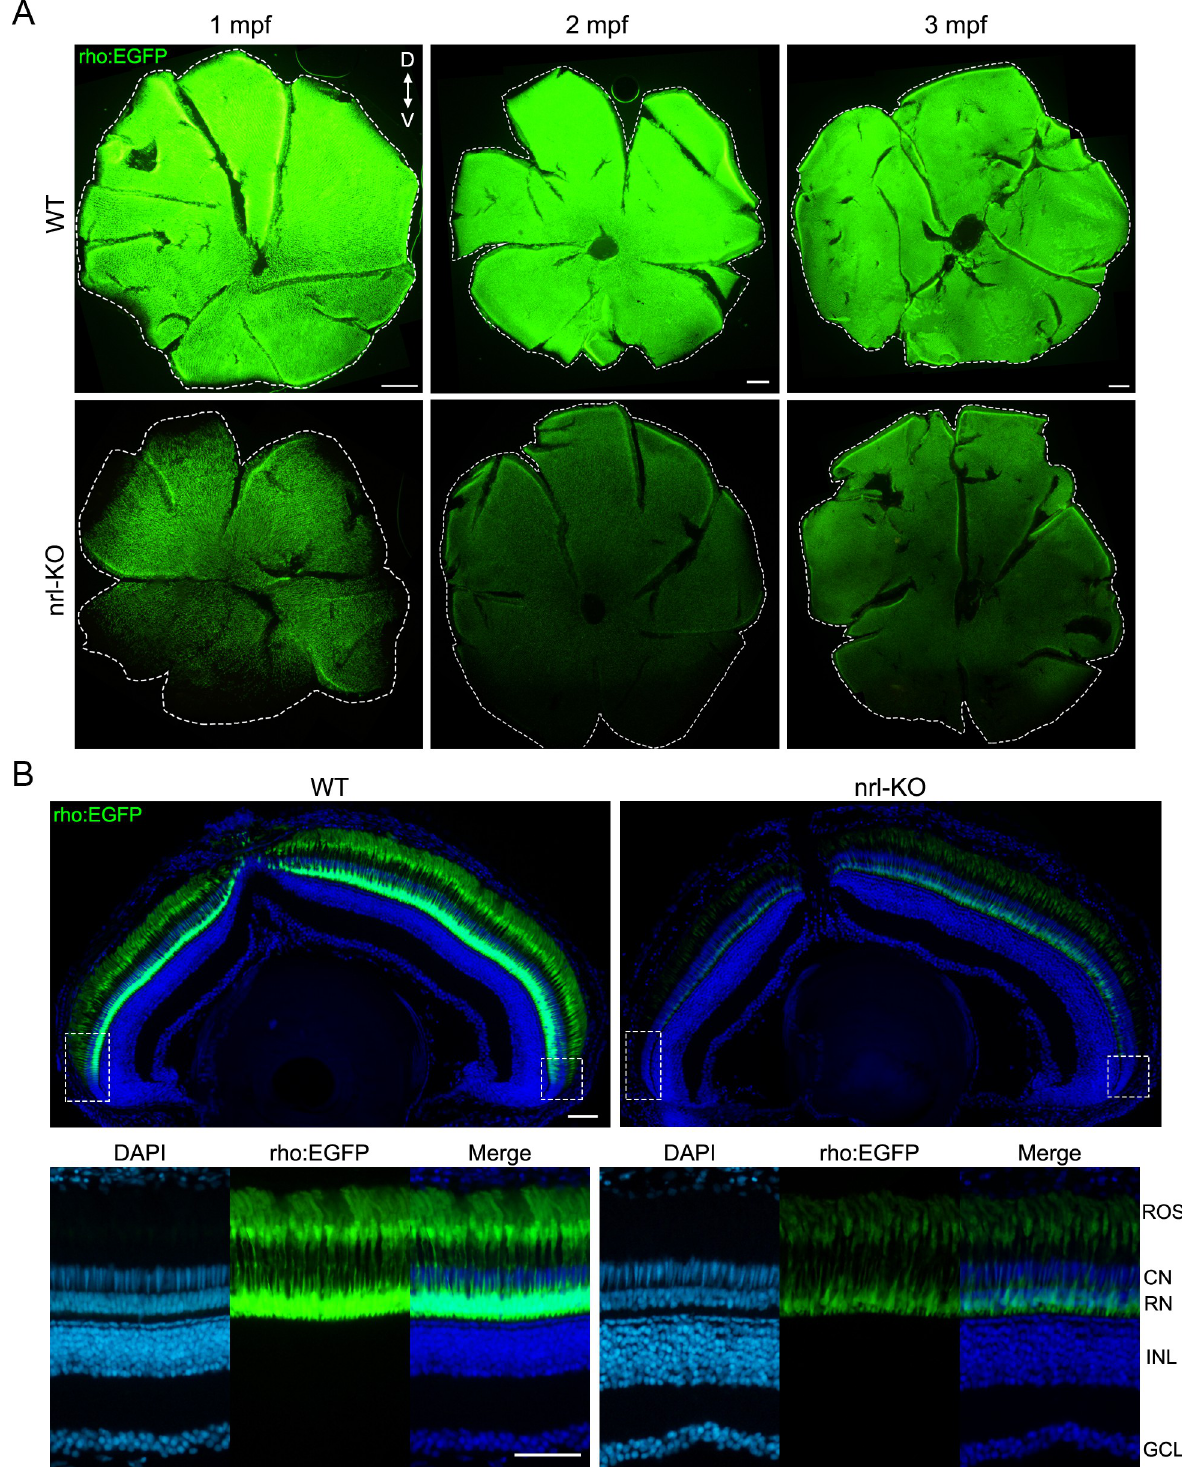
Fig 4. Distribution of the rods and expression of the rod opsin in the WT and nrl -KO retinas from 1 mpf to 3 mpf. (A) The Tg(rho:EGFP) transgenic line was used to label rods with EGFP. Representative images of flattened whole-mount retinas from WT and nrl -KO zebrafish at 1 mpf, 2 mpf, and 3 mpf are shown. The dashed lines indicate the edges of the retinas. Scale bars: 200 μ m. (B) EGFP-labeled rods were observed on the retinal sections from WT and nrl -KO Tg(rho:EGFP) transgenic zebrafish at 1 mpf. The overall views are shown in the upper panel. The